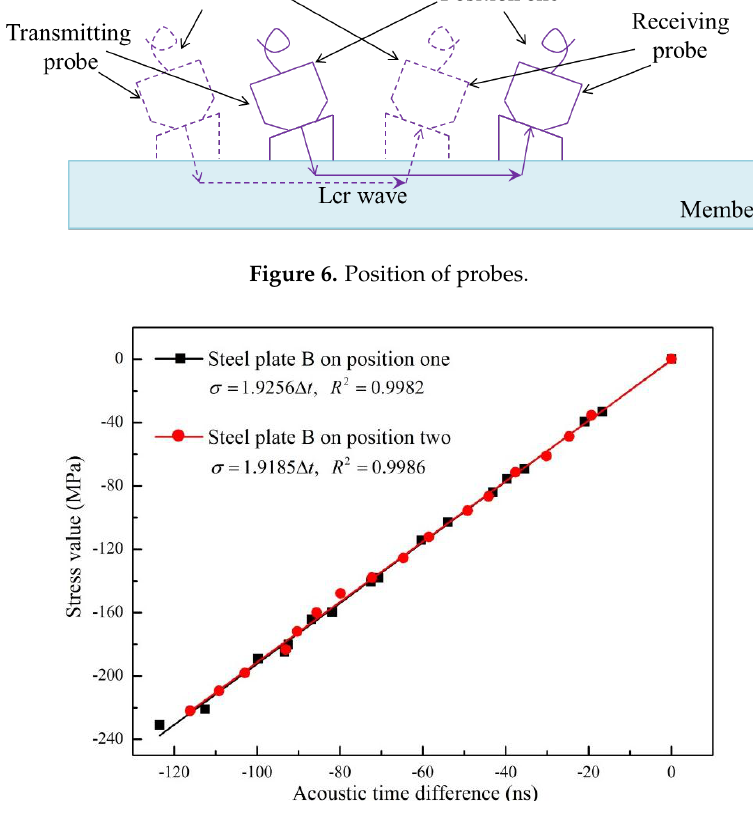
Figure 7. Fitting line between stress and TOF of steel plate B on position one and position two.